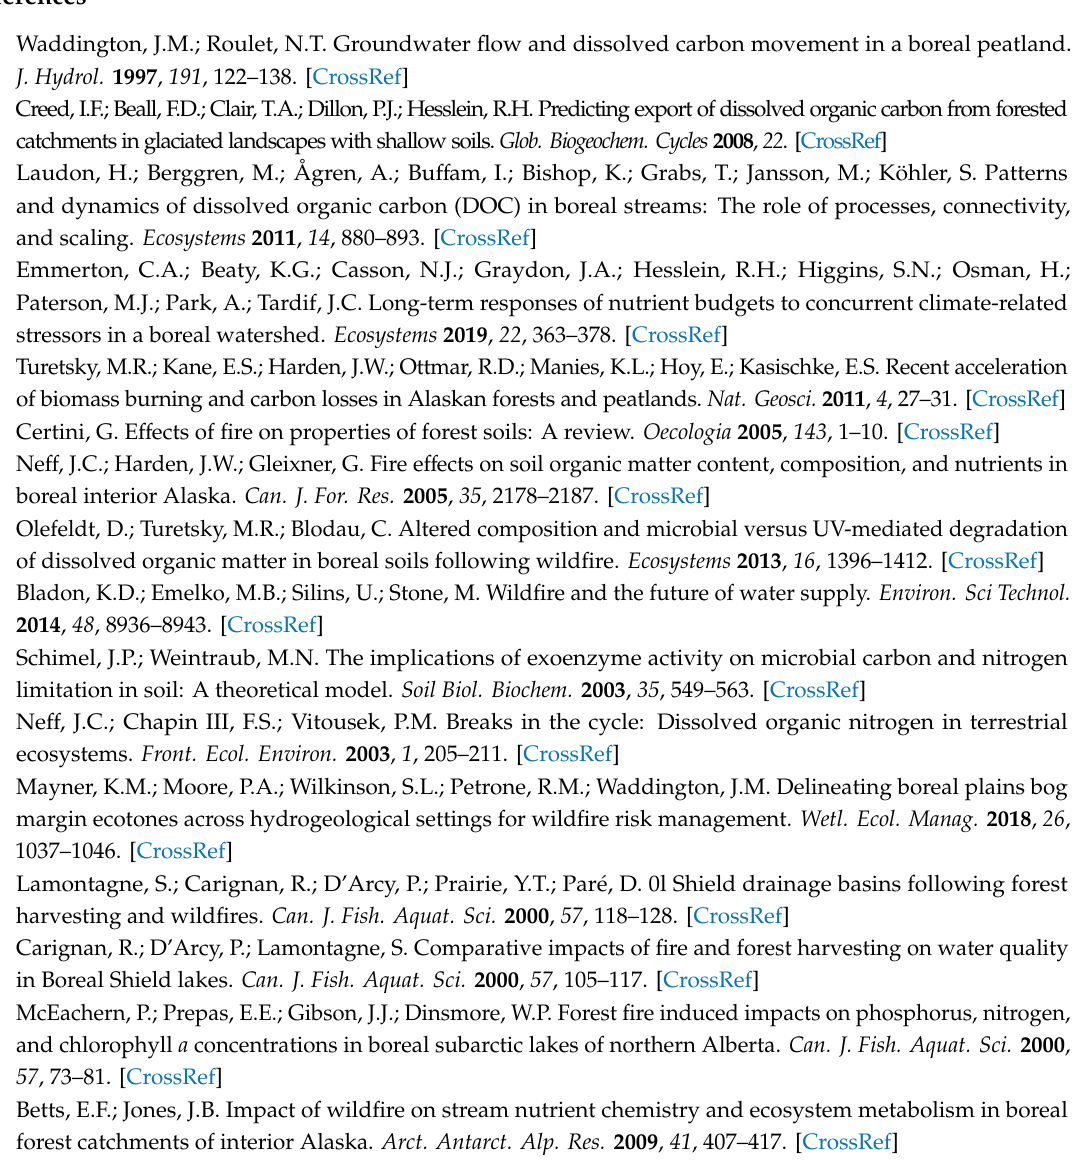
Table S1: Shallow groundwater Chemistry Results, Table S2: PRS ® -Probe (In-Situ Burials)